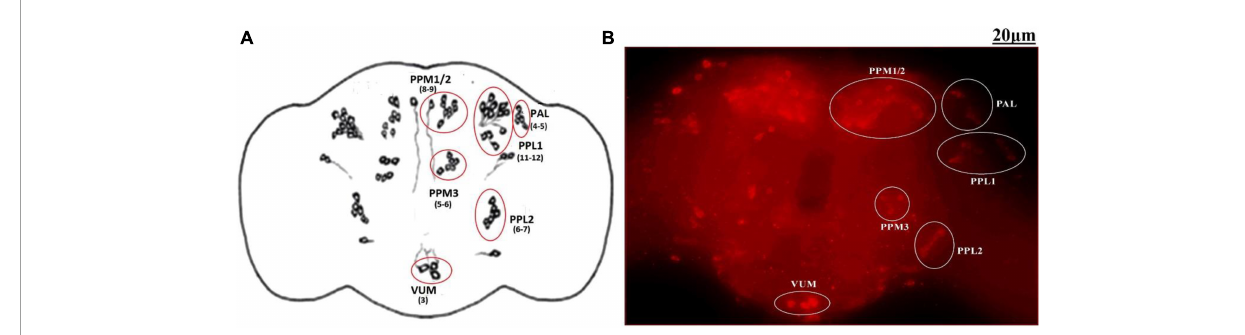
FIGURE2 Quantifiable dopaminergic neuronal clusters in whole brain of Drosophila : cartoon of Drosophila melanogaster brain illustrating the position of quantifiable DAergic neurons (A) and image of the whole-brain mount of 5 days old male Drosophila captured by ZEN software of Carl Zeiss Fluorescence Microscope using fluorescently labeled secondary antibody targeted against the primary anti-TH antibody (B) . There are around 141 dopaminergic neurons (including ∼ 100 neurons of the PAM cluster which cannot be quantified) arranged in different clusters in each hemisphere. (PAL, proto-cerebral anterior lateral; PAM, proto-cerebral anterior medial; PPL, proto-cerebral posterior lateral; PPM, proto-cerebral posterior medial; VUM, ventral unpaired medial).